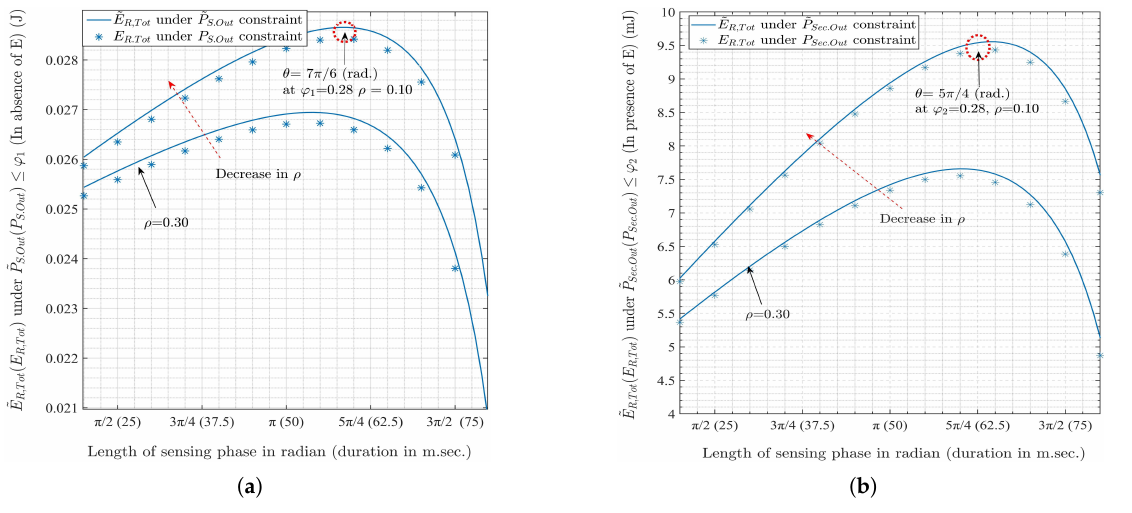
Figure 5. Exact and approximated total residual energy as a function of θ for EH-unmanned aerial vehicle (UAV) under ( a ) connection outage constraint, ( b ) secrecy outage